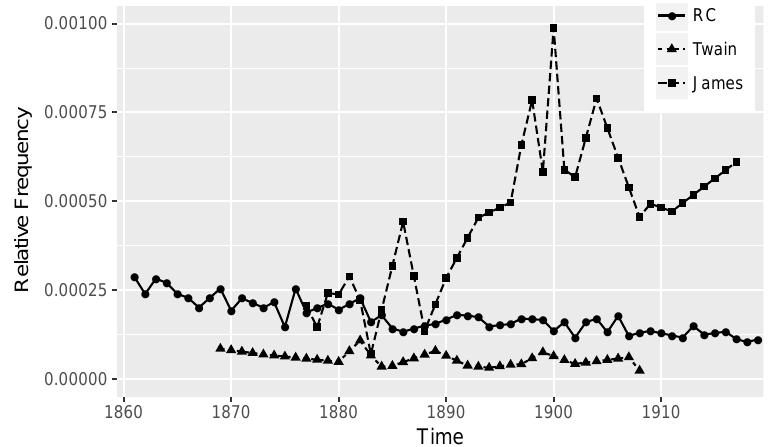
Figure 12: Prominent features common and the reference